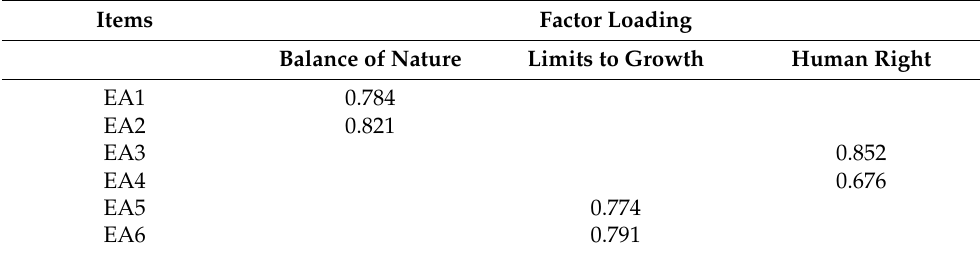
Table 3. Rotating component matrix of the environment attitude.